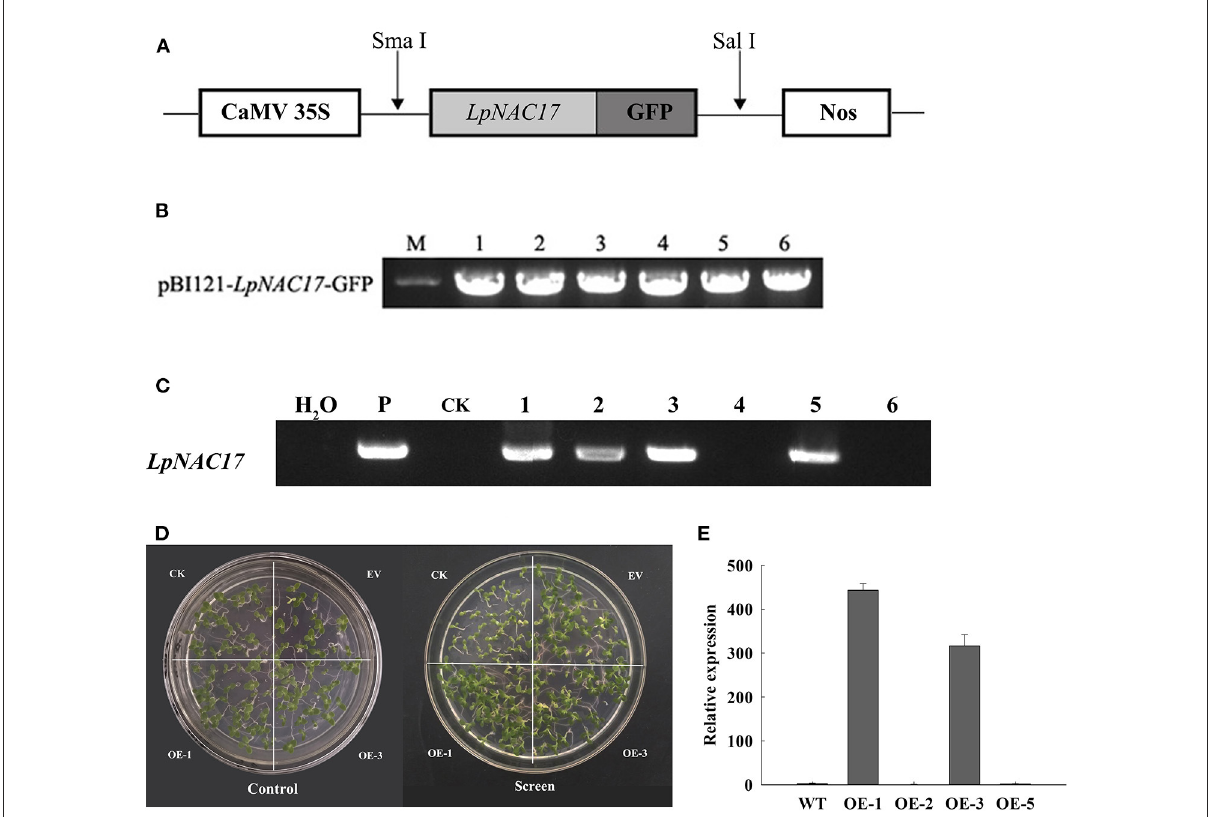
FIGURE3 Generation of transgenic tobacco overexpressing LpNAC17 . (A) Schematic diagram of T-DNA region of the expression vector containing 35S: LpNAC17-NosT . (B) Construction of binary vector pBI121- LpNAC17 -GFP. M, 2000 DNA marker; 1–6, verification of binary vectors. (C) PCR confirmation of the presence of LpNAC17 in transgenic tobacco lines. P, plasmid DNA as a positive control; H 2 O, sterile distilled water as a negative control; CK, wild-type tobacco; #1, 2, 3, and 5, transgenic tobacco lines. (D) Growth of CK, EV and the OE-1 and OE-3 lines on the media containing Kanamycin. (E) Relative expression of LpNAC17 in the transgenic tobacco lines.